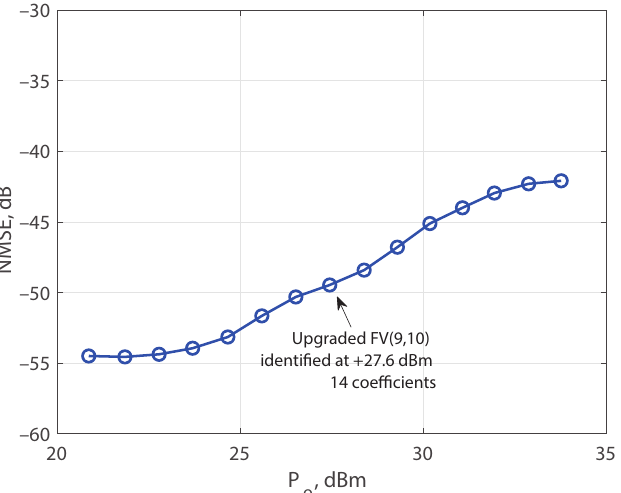
Figure 7. NMSE comparison of the upgraded FV(9,10) model in a dynamic range from 21 to 34 dBm.